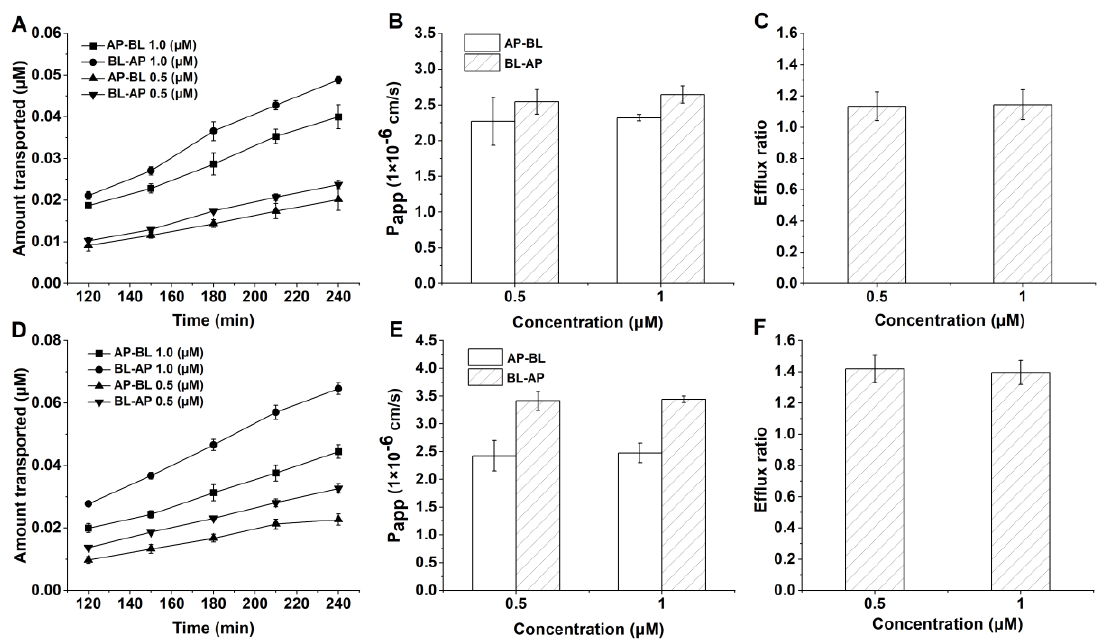
Figure 3. The Caco-2 cell monolayers were incubated with FL77-28 and FL77-29 (0.5 µ M or 1 µ M) for 4 h at 37 ◦ C. ( A ) Effect of time on the transport of FL77-28 in both directions. ( B ) Permeation studies of FL77-28 on both sides of AP-BL and BL-AP. ( C ) The efflux ratio of FL77-28. ( D ) Effect of time on the transport of FL77-29 in both directions. ( E ) Permeation studies of FL77-29 on both sides of AP-BL and BL-AP. ( F ) The efflux ratio of FL77-29. Results are shown as the mean ± SD ( n = 3).